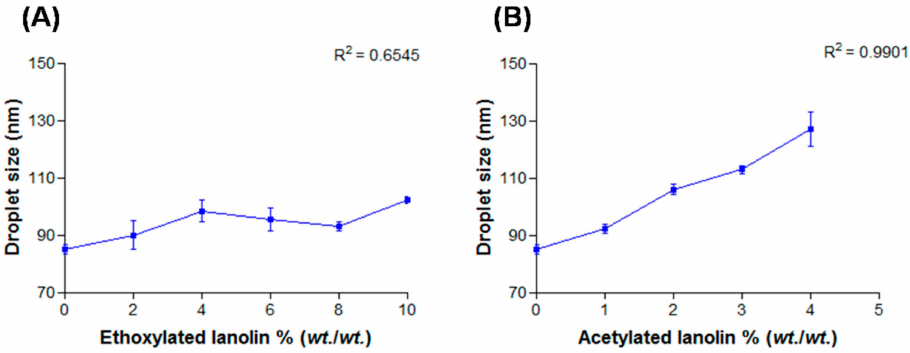
Figure 1. Droplets mean size as a function of lanolin derivatives concentration: ( A ) EL and ( B )